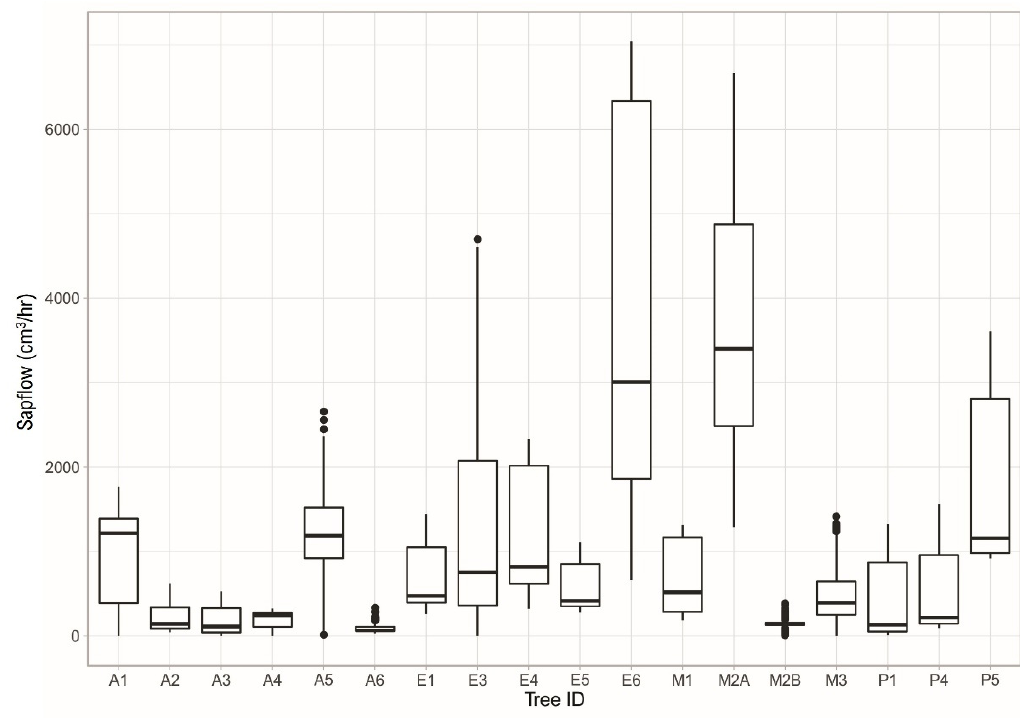
Figure 5. Boxplots showing the range of sap flow rates (with the 25th percentile, median and 75th percentile indicated by the rectangular box and potential outliers indicated with dots) for each of the individual trees monitored.